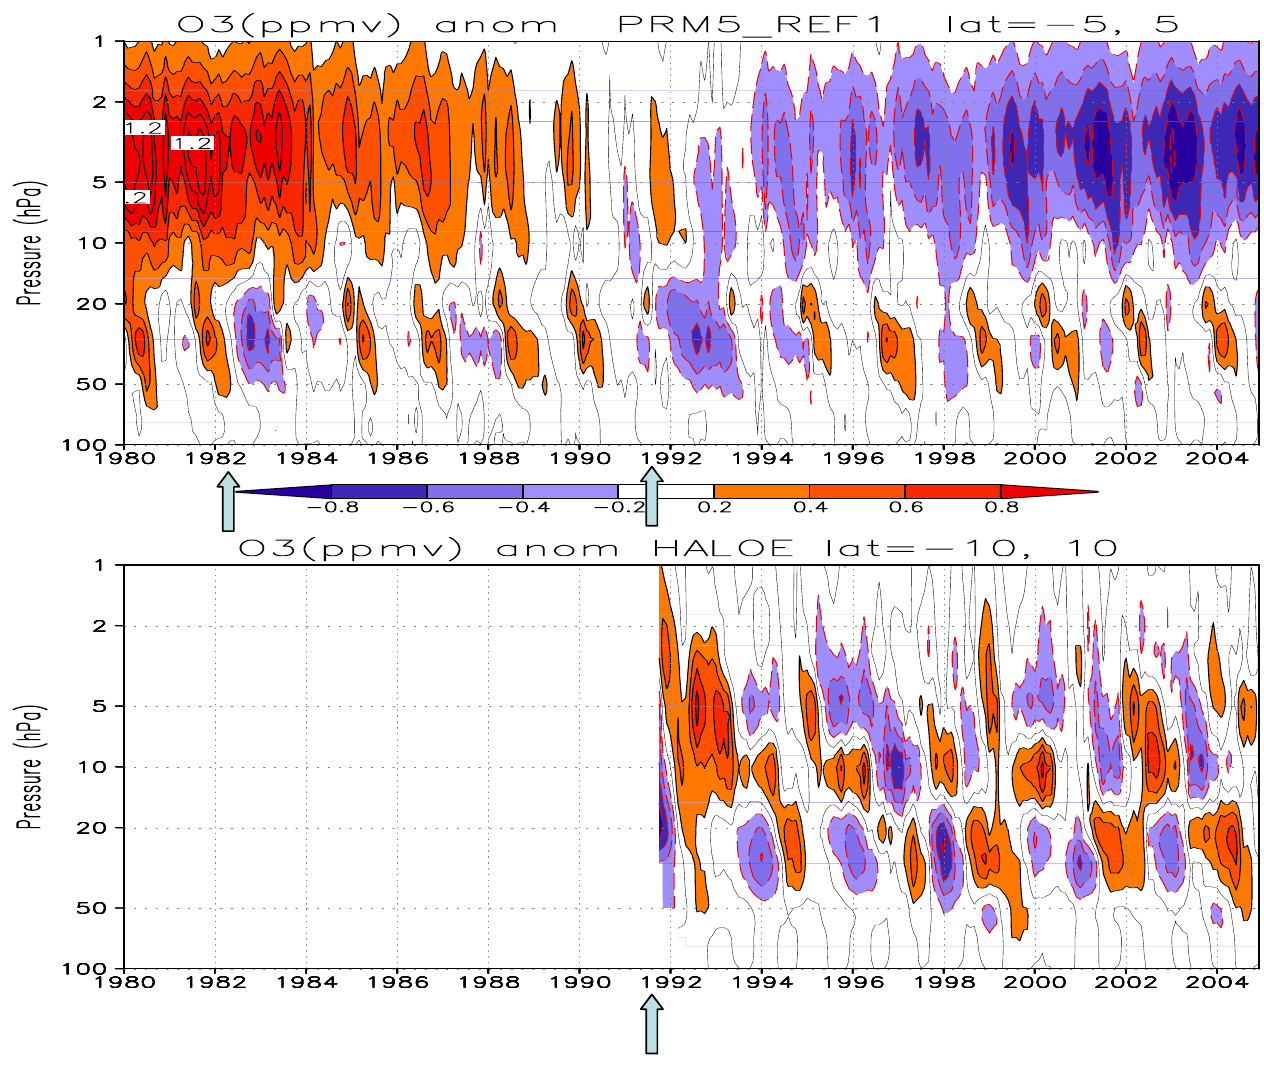
Fig. 3 Same as in Fig. 2 except for the deseasonalized zonal-mean ozone of the simulation (upper) and observation (HALOE) (lower). Contour interval is 0.2 ppmv.